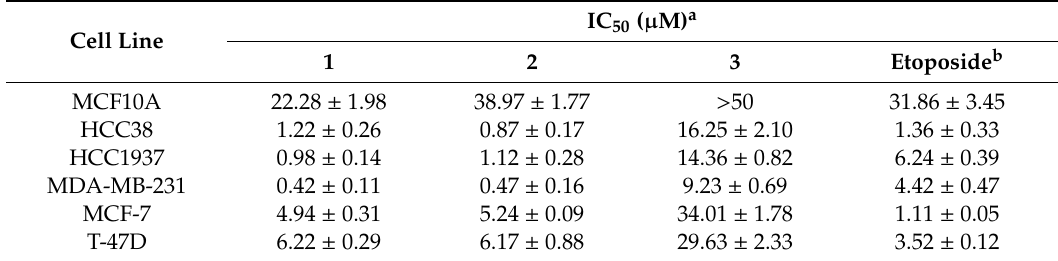
Table 1. Antiproliferative activities of NepA analogs against a panel of human BC cell